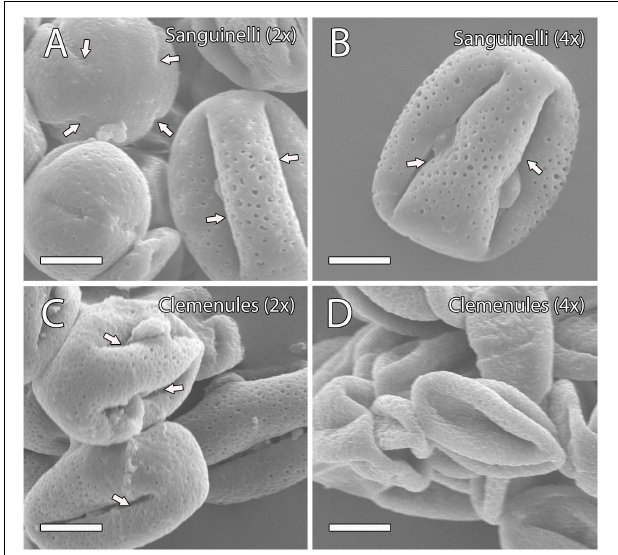
FIGURE 1 | Observation of mature pollen grains of the four genotypes under study at anthesis by scanning electron microscopy (SEM). (A–D) Mature pollen grains showing a globose-ellipsoid shape in (A) diploid and (B) doubled diploid “Sanguinelli” and (C) diploid “Clemenules” with four aperture sites (arrows); however, the pollen grains of (D) doubled diploid “Clemenules" appeared shrunk. All scale bars: 10 µ m. Diploid (2x) and doubled diploid